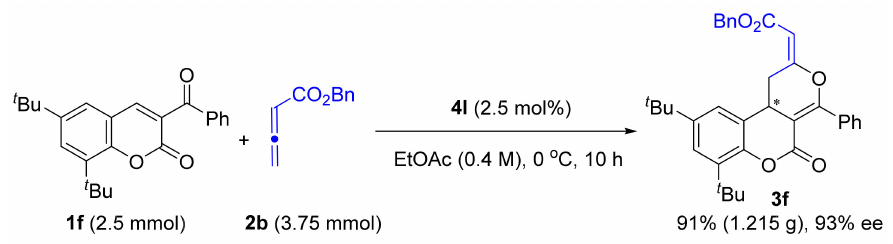
Figure 4. Gram-scale synthesis and product